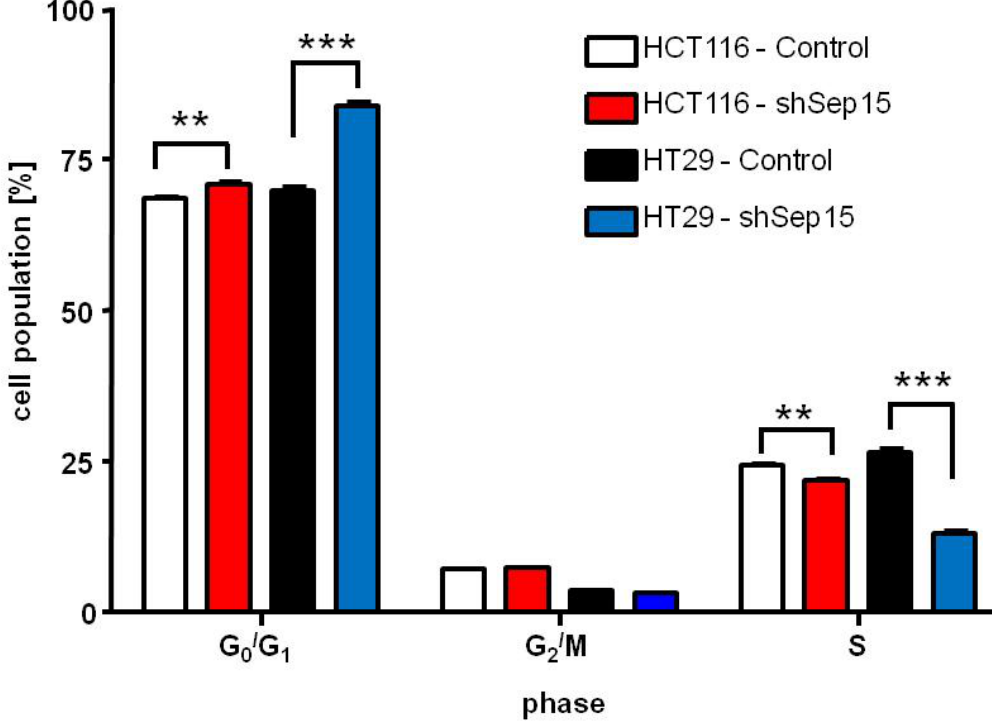
Figure 5. Cell cycle analysis of HCT116 and HT29 cells. Percent of cells in each phase of the cell cycle as determined by FACS analysis at six hours after release from synchronization with serum is shown. Values are means ± SE ( t -tests, n =